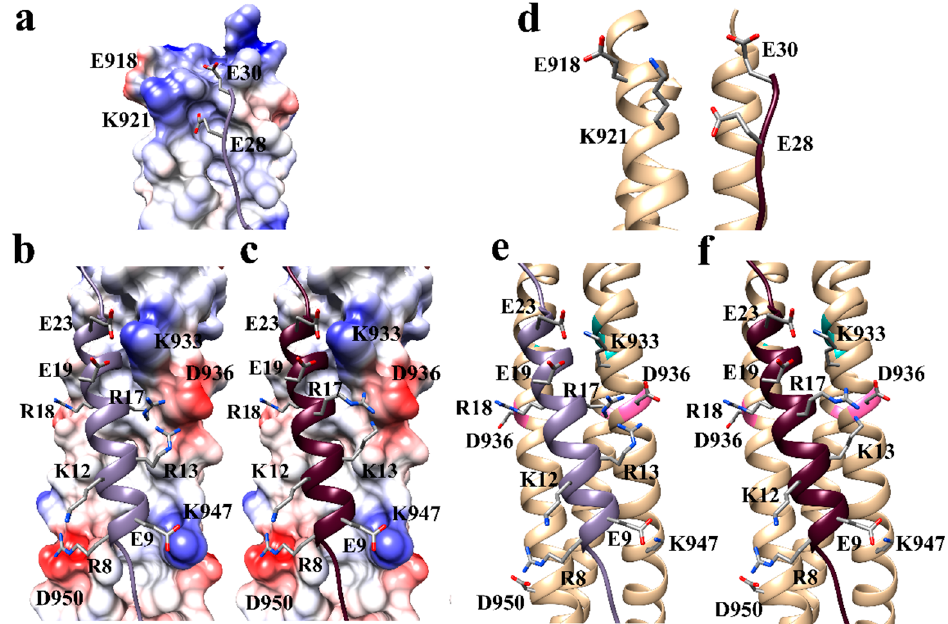
Figure 9. Electrostatic interactions between SARS-CoV-2 HR1 domain (electrostatic surface) and ( a ) C terminal region of 130A2, ( b ) 130A2 helix region, and ( c ) 132B helix region. The red color indicates regions of negative charge, the blue indicates regions of positive charge. The white color indicates regions of neutral charge. Electrostatic interactions between SARS-CoV-2 HR1 domain, ( d ) C terminal region of 130A2, ( e ) 130A2 helix region, and ( f ) 132B helix region in ribbon and atom and bond format.